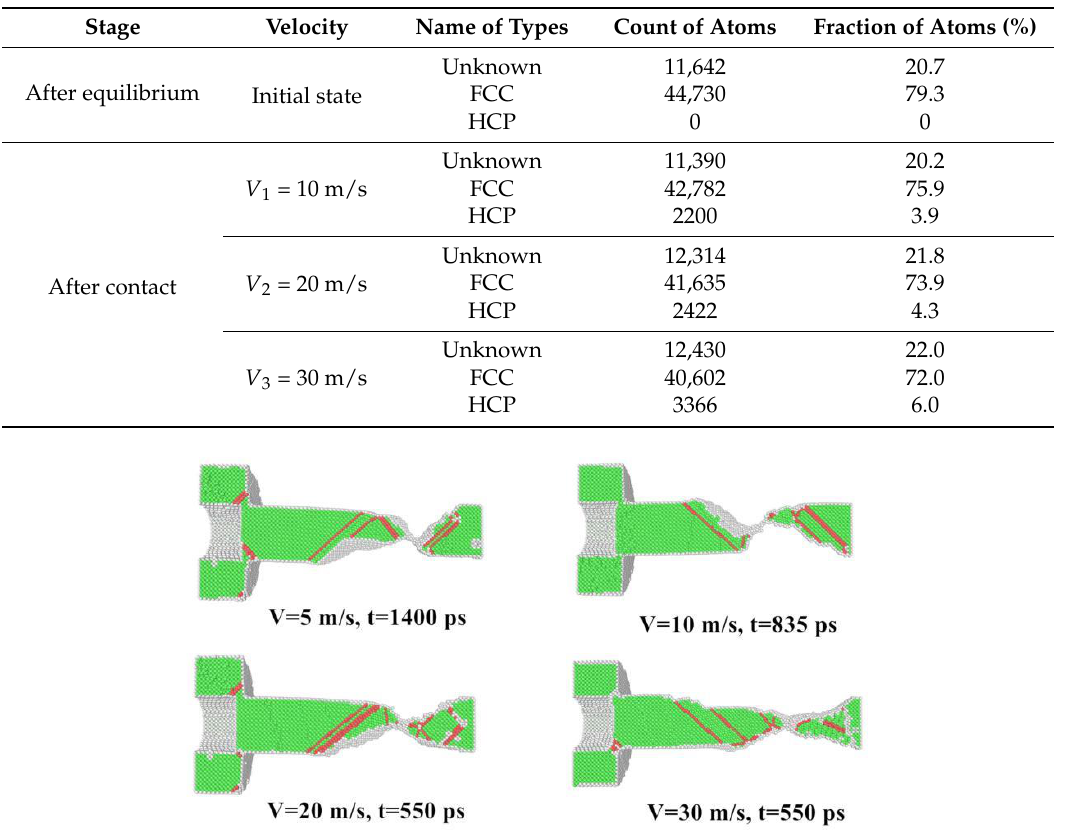
Figure 7. CNA graph for different stretching velocity before the fracture.